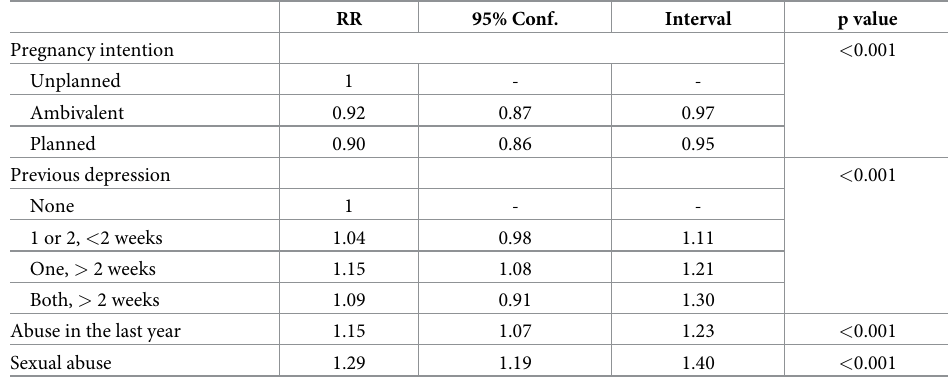
Table 3. Multivariable regression of pregnancy intention and any symptoms of depression.